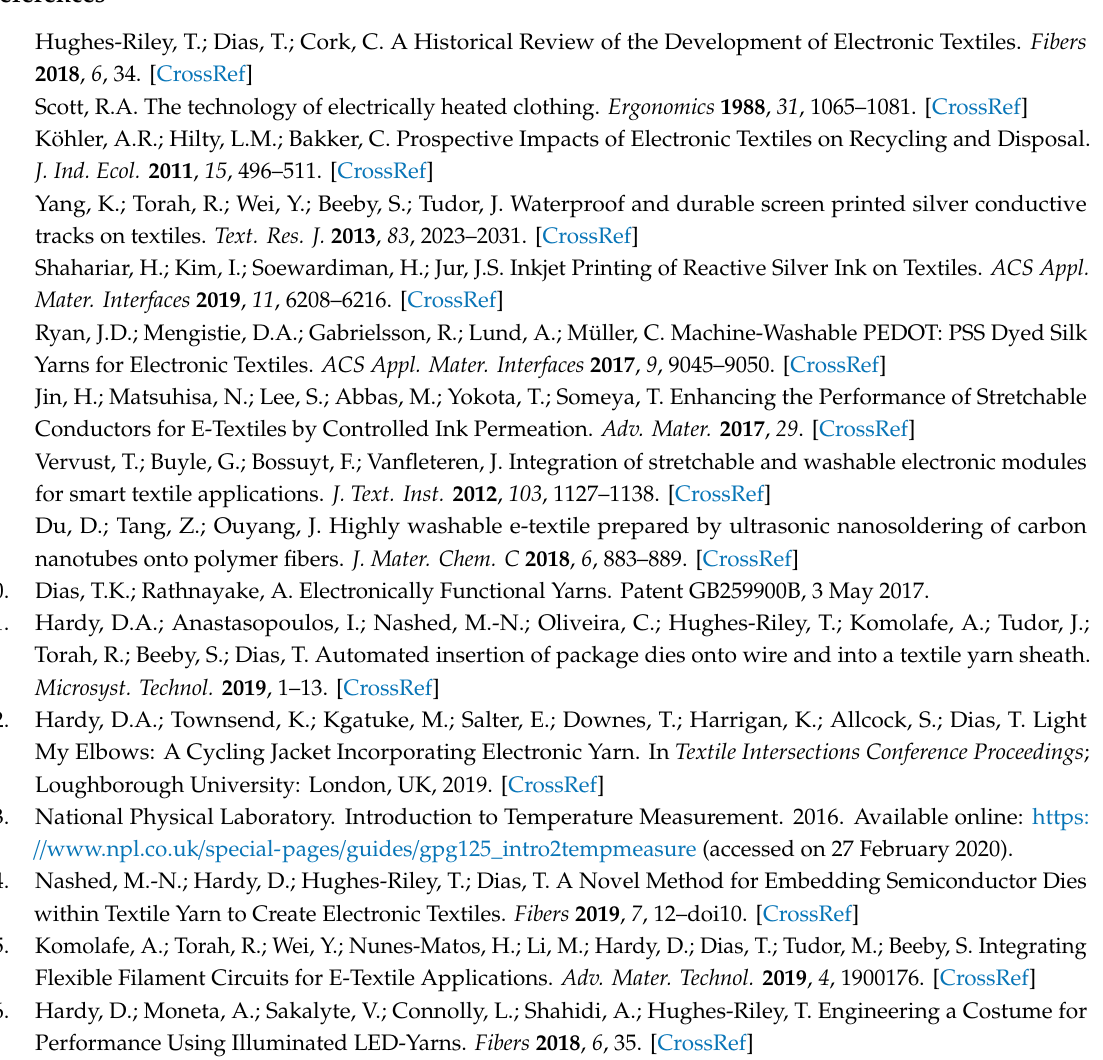
first wash. Figure S2. Acoustic E-yarns machine washed, and tumble dried within channels in a woven textile. Each image shows acoustic measurements from the E-yarns after machine washing and tumble drying. (d) Shows results from the only E-yarn that was functioning after 25 washes. Figure S3. Acoustic E-yarns machine washed, and line dried in pockets attached to a T-shirt. Figure S4. Acoustic E-yarns machine washed, and line dried within channels in a woven textile. Results (b), (c) and (d) show partial functionality retained after 25